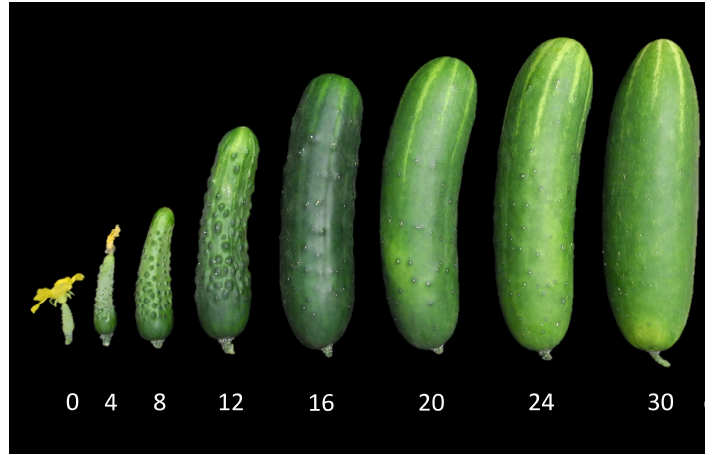
Figure 3. Growth of cucumber (cv. Poinsett) fruit from 0–30 days post-pollination